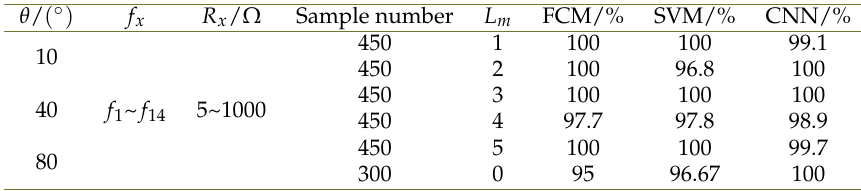
Table 5. Testing results of line selection of different fault angles